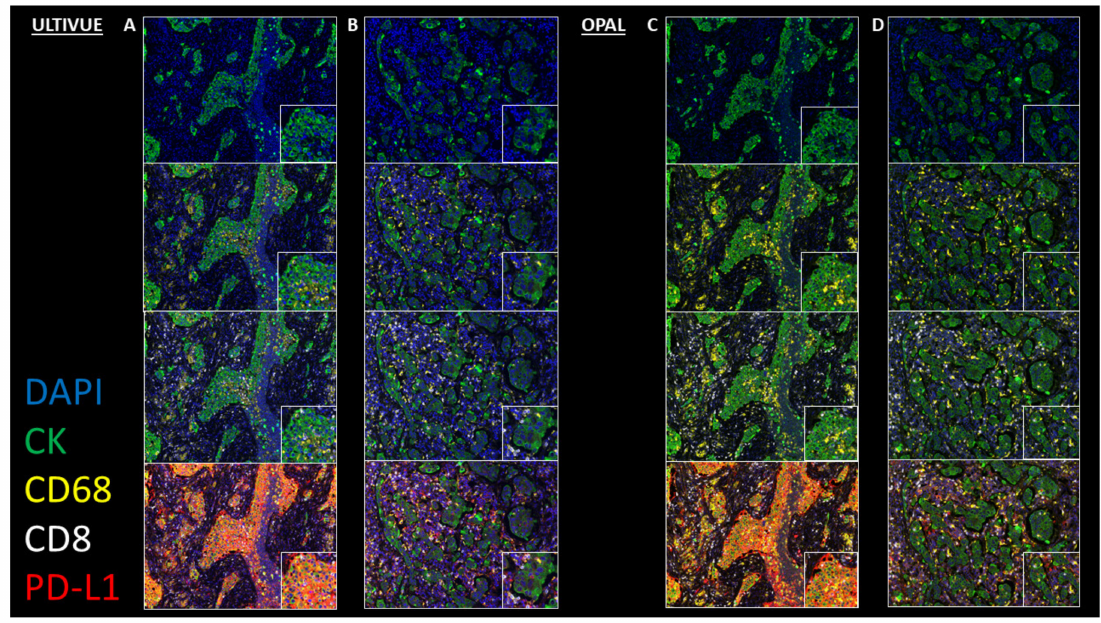
Figure 3. Representative images of comparative multiplex methodologies. High PD-L1 expressing case: ( A ) ULTIVUE ( C ) OPAL. Low PD-L1 expressing case: ( B ) ULTIVUE ( D ) OPAL. In each column of images, progressive channels are included. From top to bottom, images contain DAPI +/ CK + initially (blue / green), followed by addition of CD68 (yellow), CD8 (white), and PD-L1 (red). Each image includes a high powered magnification field of view ( × 20 magnification). In all composite images ( × 8 magnification), PD-L1 +/ CD68 + and PD-L1 +/ CD8 + cells are clearly distinguishable in the tumor bed.